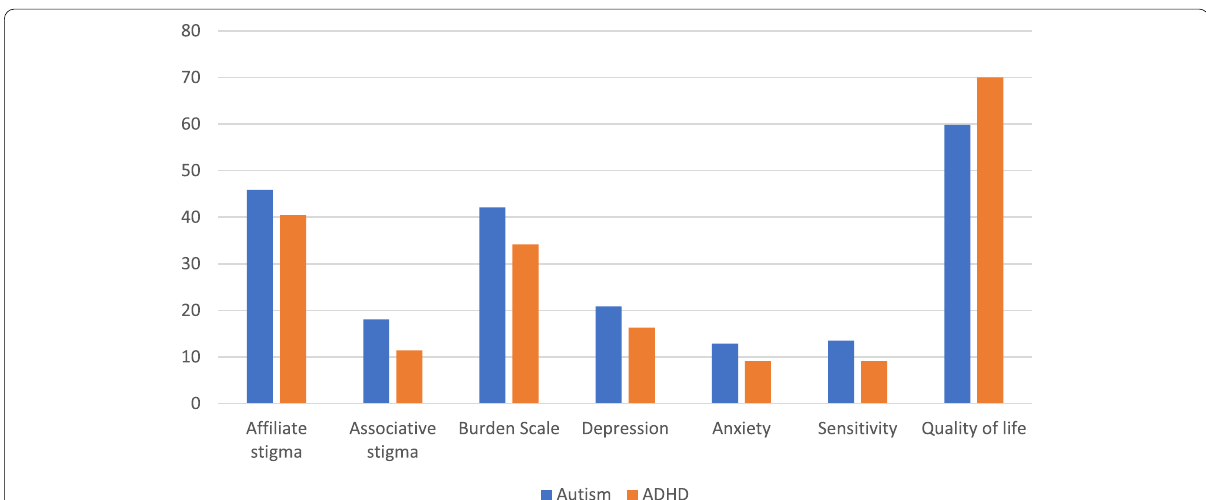
Fig. 1 Difference in affiliate stigma and associative stigma, burden scale, and anxiety, sensitivity, and quality of life between caregivers of autism and caregivers of ADHD